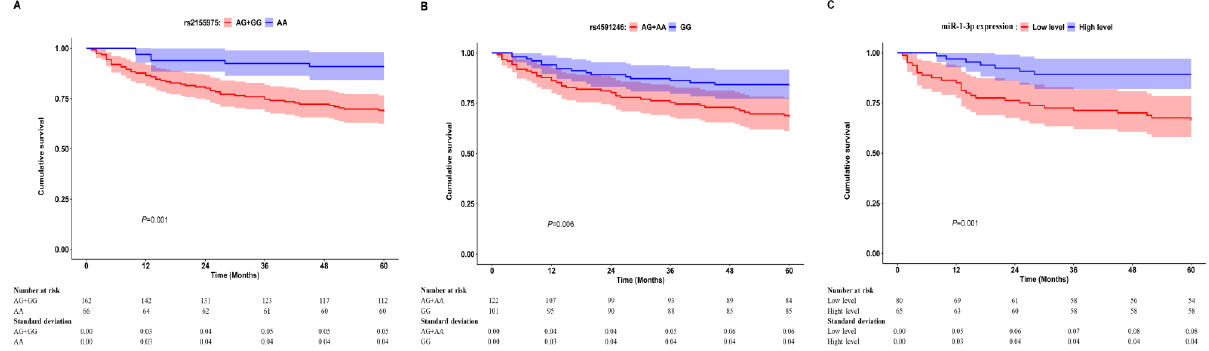
Figure 1. Kaplan – Meier estimates of the cumulative survival in patients after AAA repair according to SNP rs2155975 ( A ) and rs4591246 ( B ) as well as miR-1-3p expression ( C ). Shaded region indicates 95% confidence interval (CI).